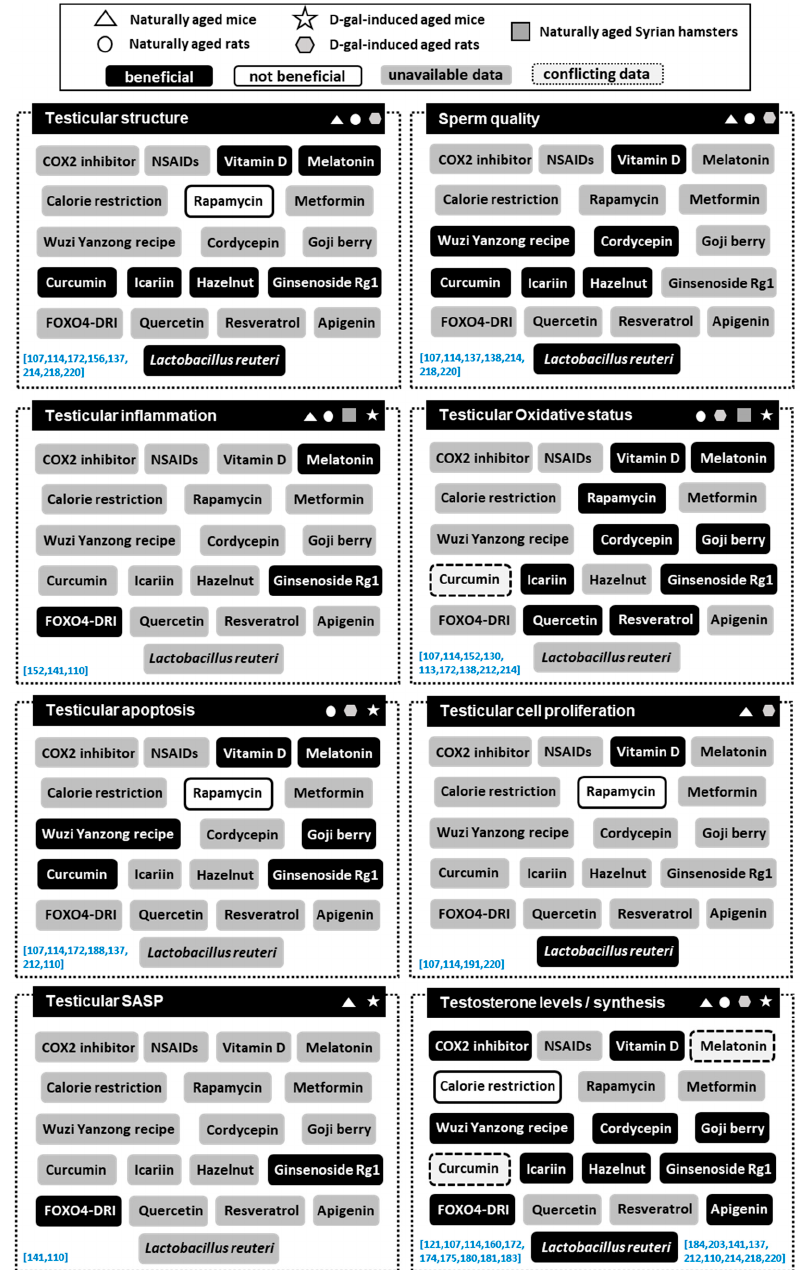
Figure 2. Effects of main anti-aging interventions on testicular aging in different experimental animals. Main anti-aging interventions were categorized into beneficial or not beneficial according to their ability to reverse aging-related testicular alterations. Conflicting results or lack of data on the different interventions were also included. Corresponding references are listed between brackets (blue).